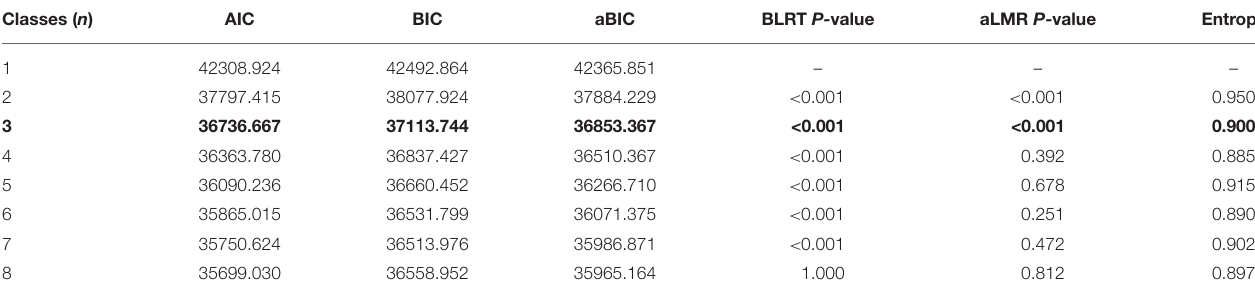
TABLE 2 | Model fit statistics for latent profile analysis in the males ( N =